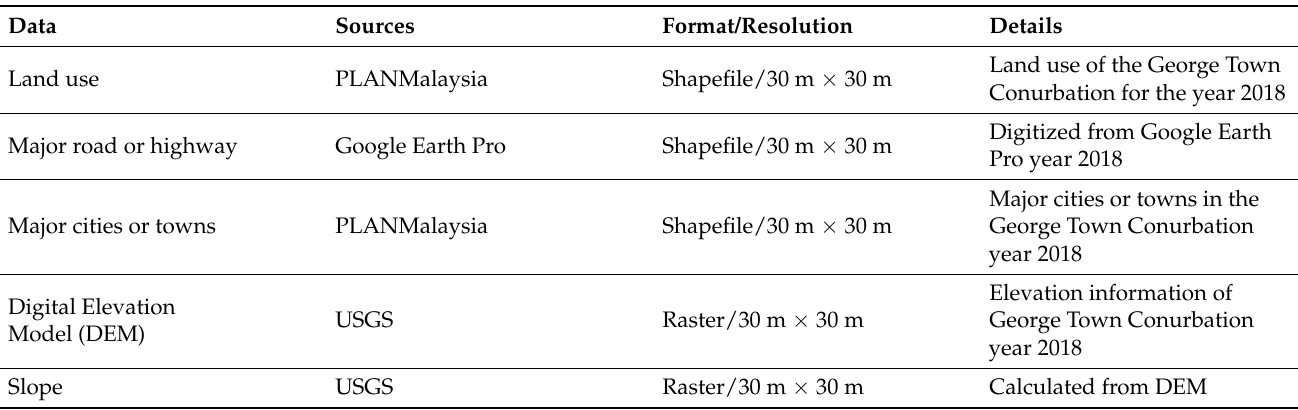
Table 3. Geospatial data sources and their